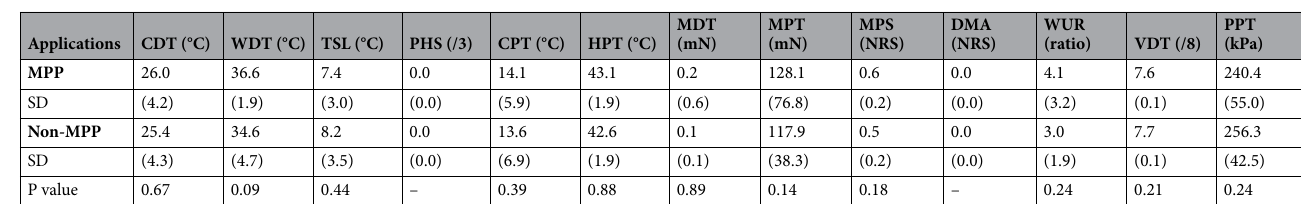
Table 2. Comparison of quantitative sensory testing (QST) results between masseter muscle pain prone (MPP) group and non-masseter muscle pain prone (non-MPP) group for first dorsal interosseous (FDI) muscle. All data are presented as mean and standard deviations of the mean. CDT = cold detection threshold (°C) ; WDT = warm detection threshold (°C) ; TSL = thermal sensory limen (°C) ; PHS = paradoxical heat sensation (score/3) ; CPT = cold pain threshold (°C) ; HPT = heat pain threshold (°C) ; MPT = mechanical pain threshold (mN) ; MPS = mechanical pain sensitivity (mean pain rating, 0–100) ; DMA = dynamic mechanical allodynia (NRS) ; WUR = wind-up ratio; MDT = mechanical detection threshold (mN) ; VDT = vibration detection threshold (score/8) ; PPT = pressure pain threshold (kPa) .